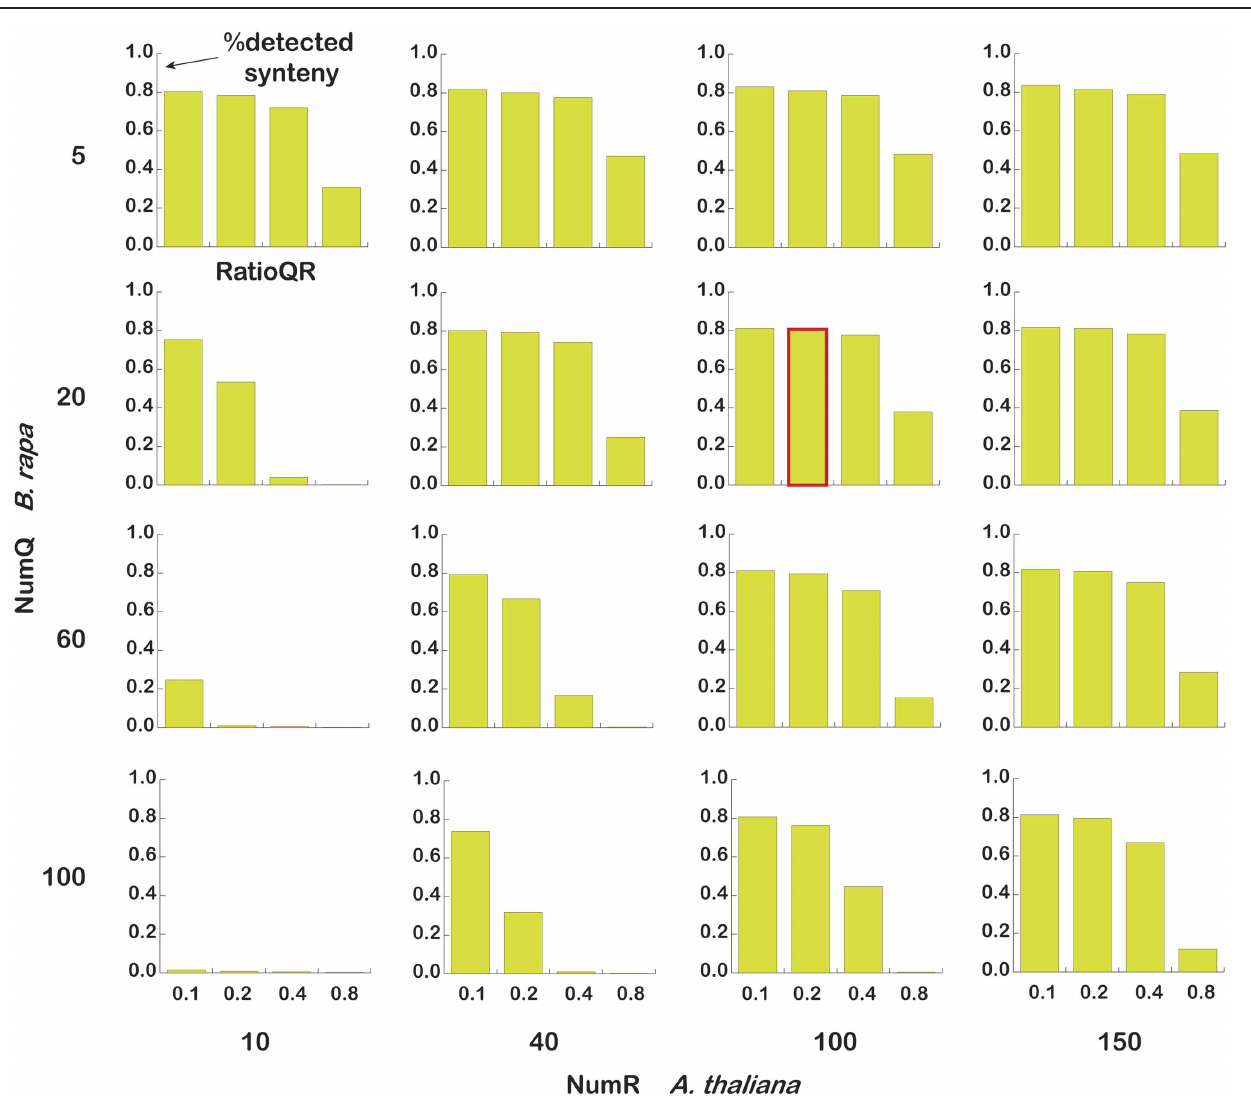
B. rapa genes, “%detected synteny” means percent of identified syntenic genes to the 38,161 B. rapa genes. The bar with a red border is the run with parameters NumQ = 20, NumR = 100, and RatioQR = 0.2; SynOrths returned stable and relatively more syntenic genes under these